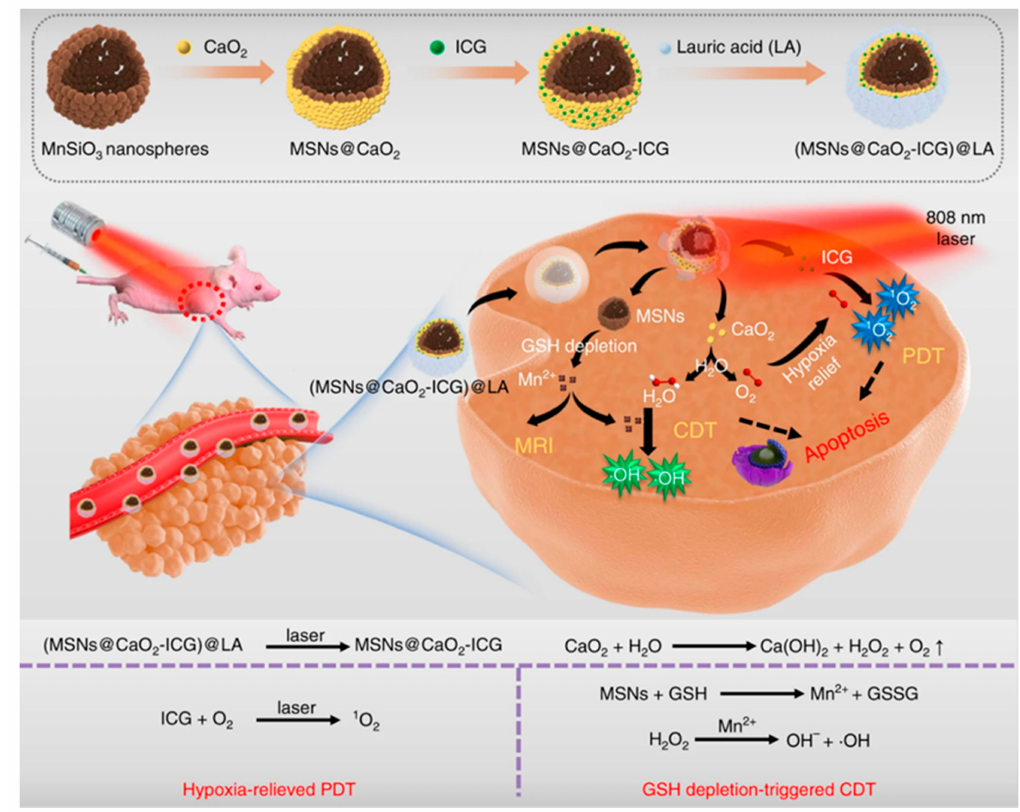
Figure 10. The scheme of fabrication process and therapeutic mechanism of thermo-responsive (MSNs@CaO 2 -ICG)@LA NPs for synergistic CDT/PDT with H 2 O 2 /O 2 self-supply and GSH depletion. Adapted from